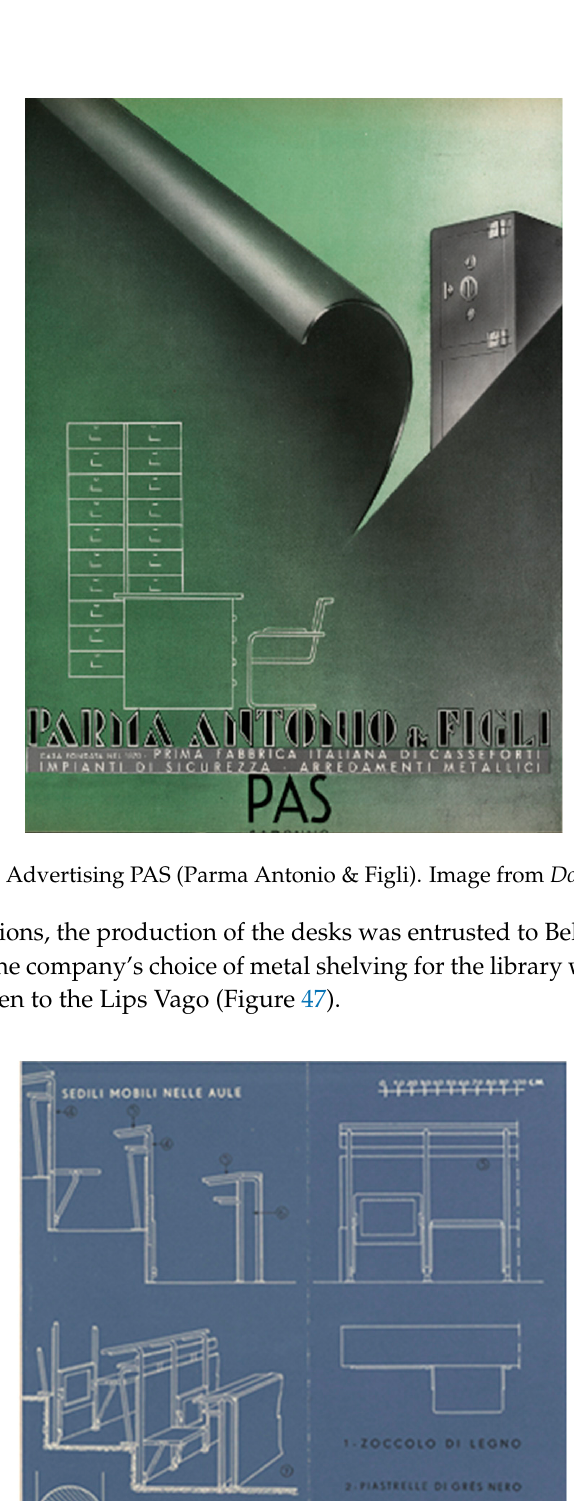
Figure 44. Technical drawing of articulated bench. Image from (De Smaele 1936, p. 20).